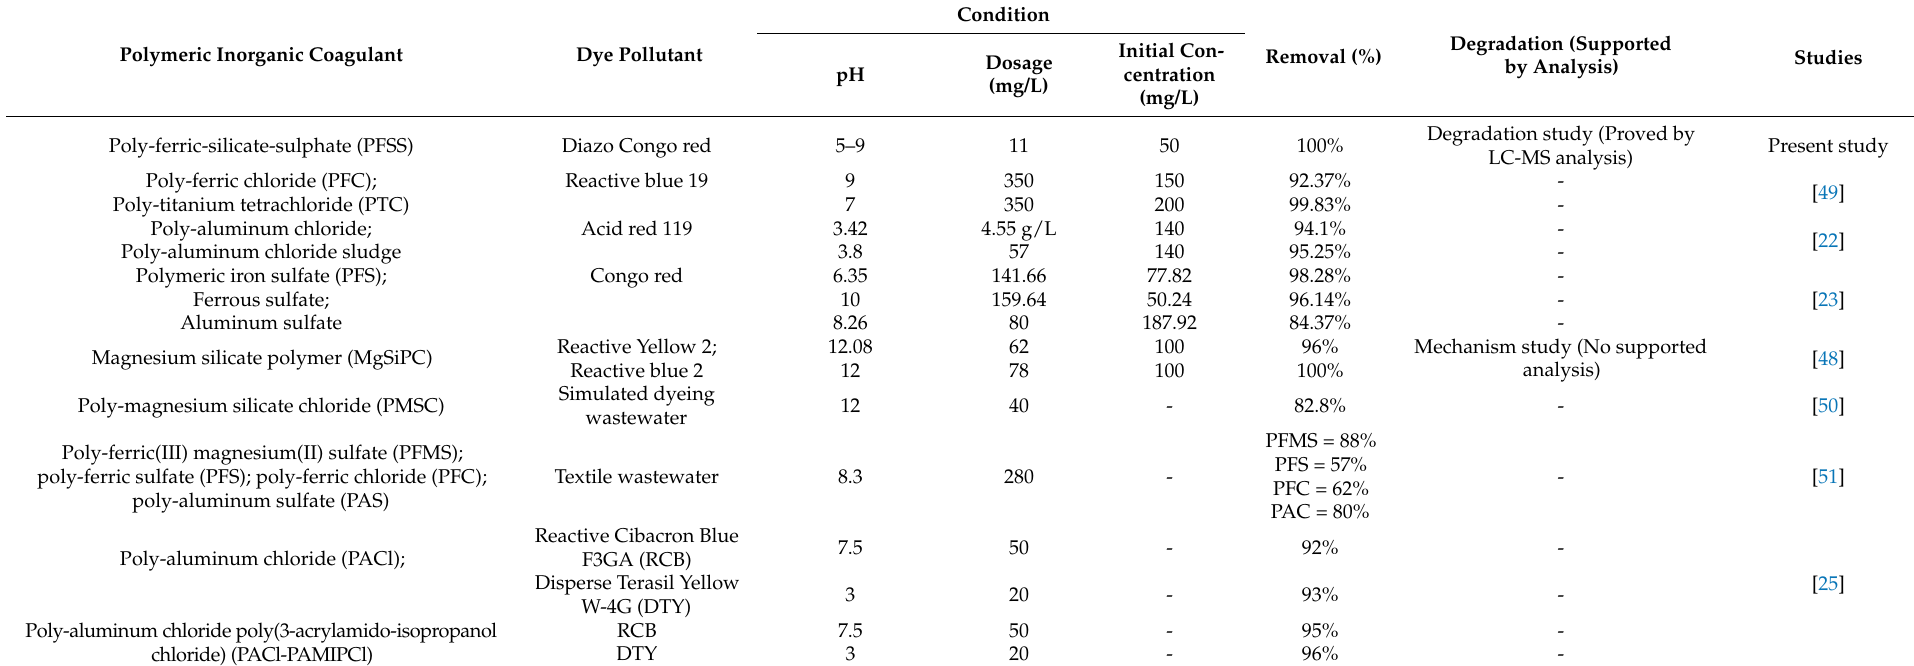
Table 1. Comparison of the PFSS in this study with other polymeric inorganic coagulants in the coagulation of dye solution.